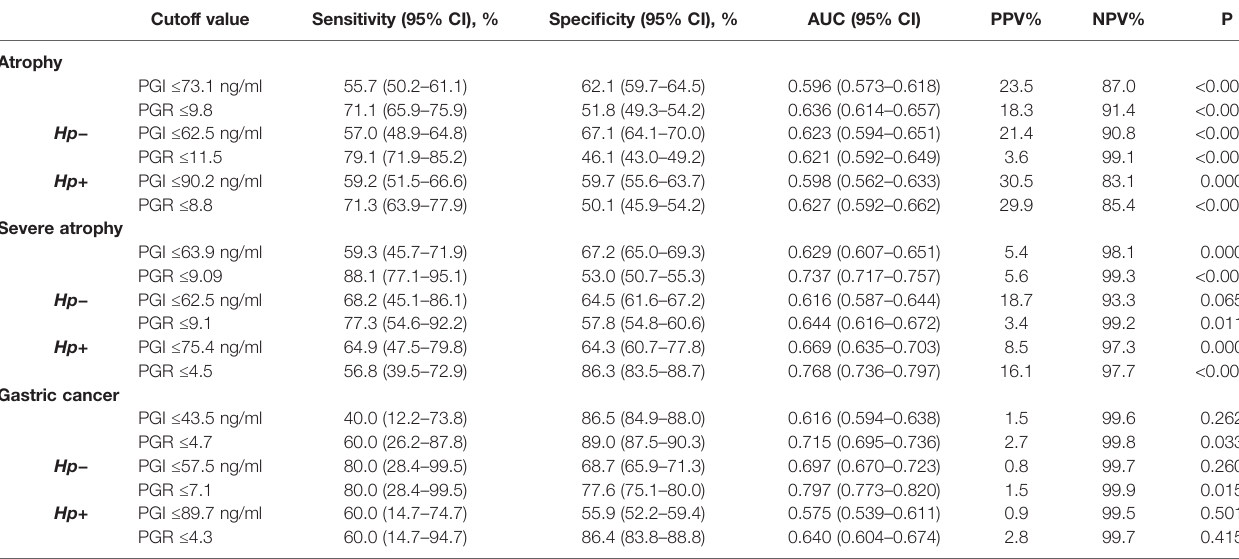
TABLE 4 | Diagnostic value of PG for atrophy, severe atrophy, and gastric cancer. Cutoff